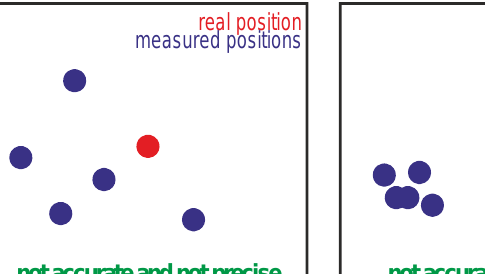
real position measured positions